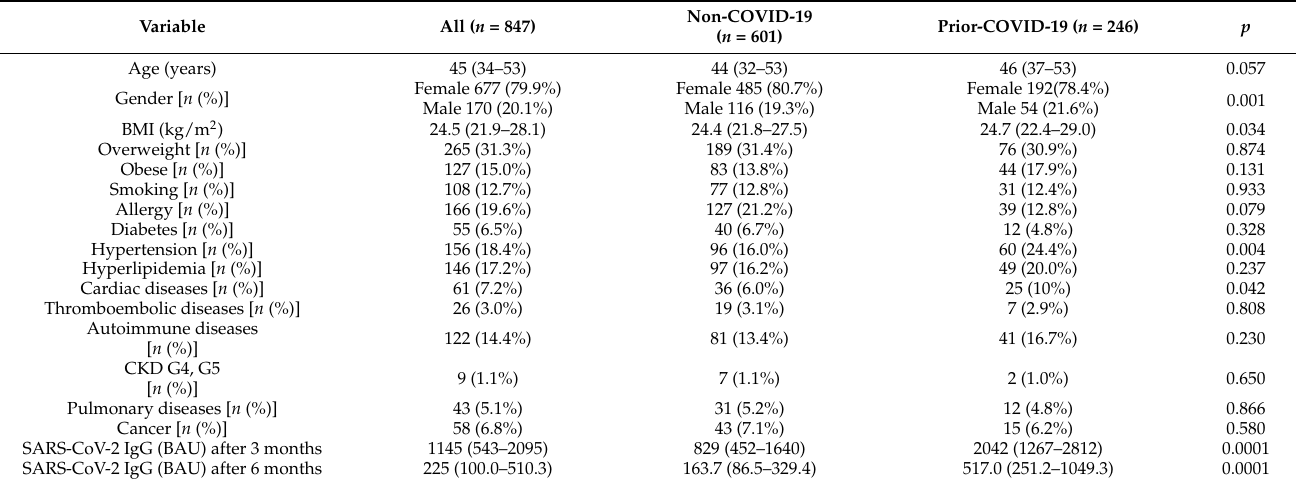
Table 1. Baseline characteristics of study